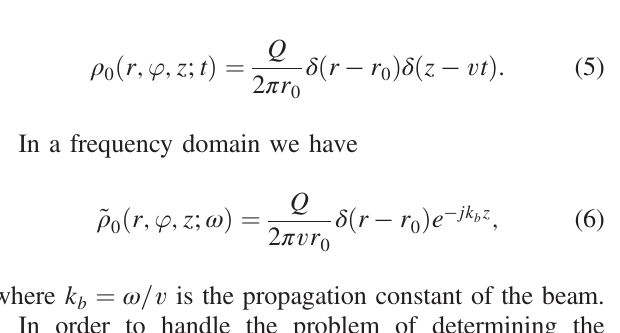
TABLE II. TM waves in region I and